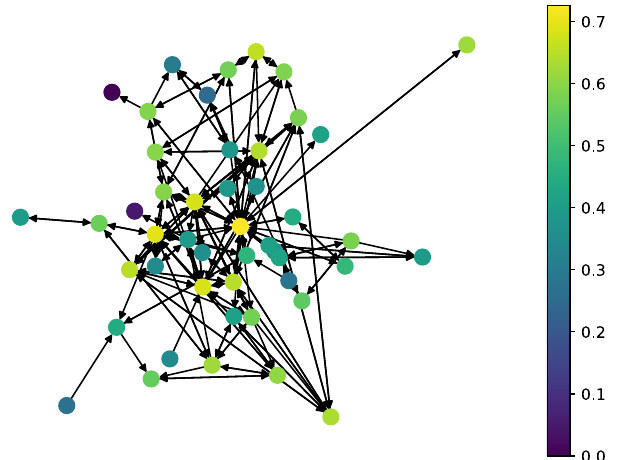
FIG. 4. Collaboration network from the Fall 2020 course at CU Boulder. This network does not show 16 disconnected nodes representing students for whom no collaborations were reported. Nodes are colored based on the outward directed closeness centrality c Co